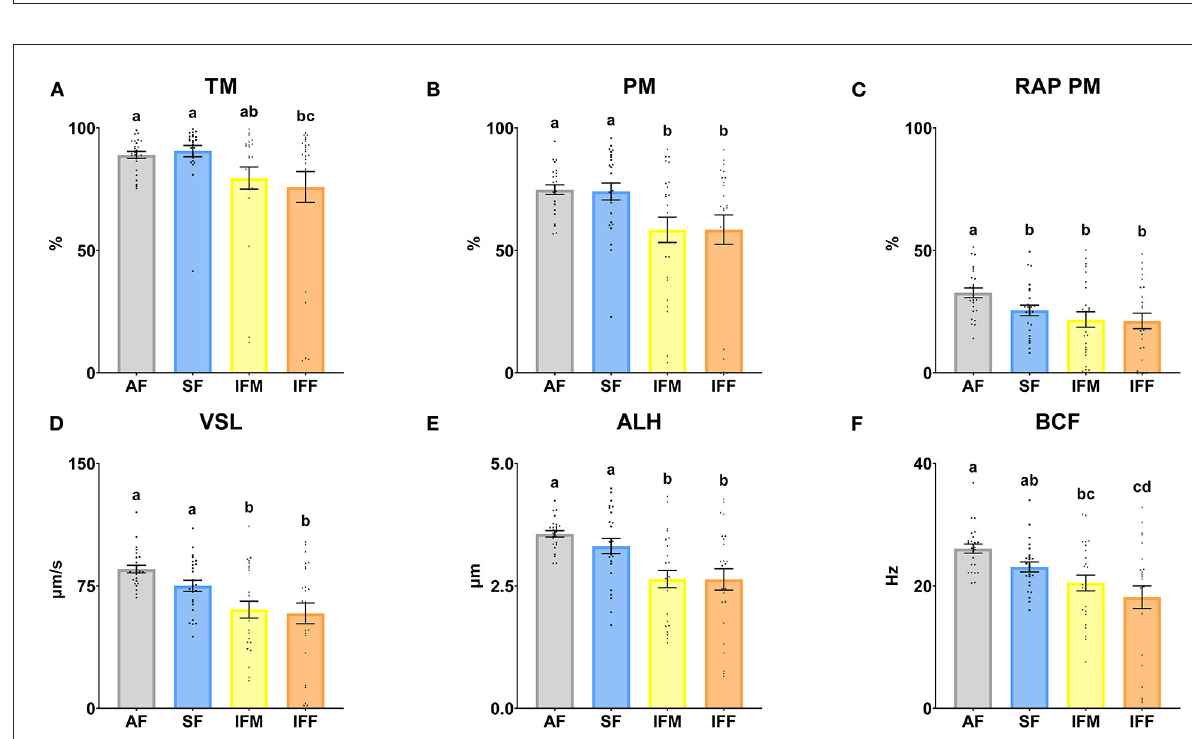
FIGURE6 Ram sperm motility according to ejaculate collection frequencies. (A) TM, total motility (%); (B) PM, progressive motility (%); (C) RAP PM, rapid progressive motility (%); (D) VSL, straight-line velocity ( µ m/s); (E) ALH, head lateral amplitude ( µ m); (F) BCF, beat frequency (Hz). The same 25 males were analyzed in each experimental group (AF, abstinence semen collection frequency; SF, standard semen collection frequency; IFM, intensive semen collection frequency on Monday; and IFF, intensive semen collection frequency on Friday). Graph dots represent individual male values. Means ( ± SEM) are shown. Different lowercase superscripts letters (a–d) indicate differences ( P ≤ 0.05) among the semen collection